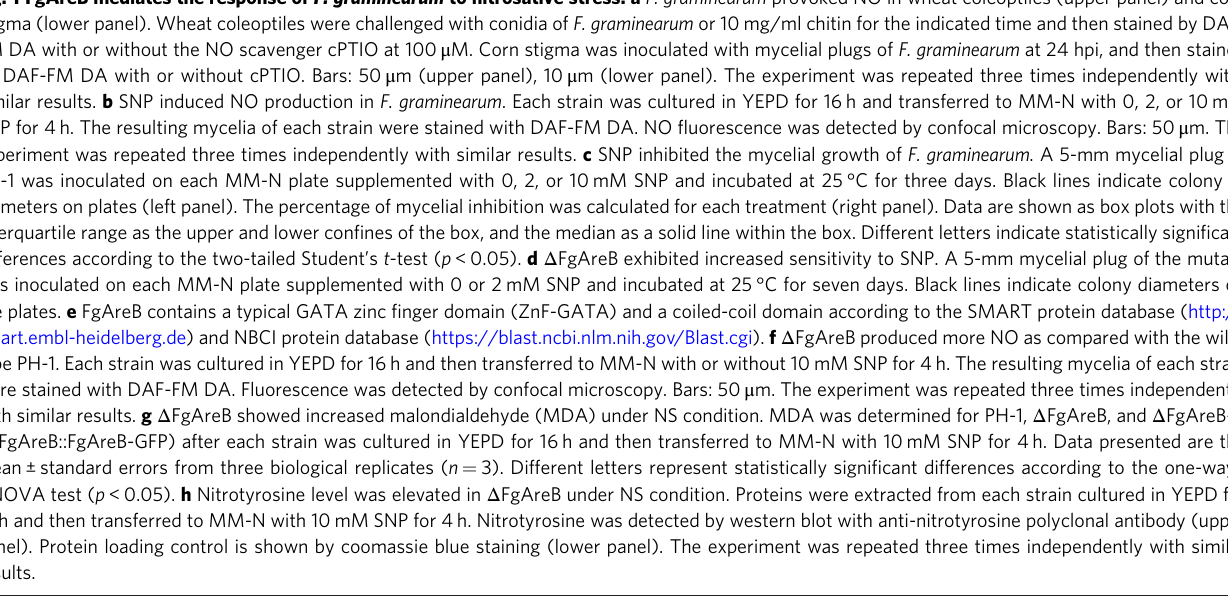
Fig. 1 FgAreB mediates the response of F. graminearum to nitrosative stress. a F. graminearum provoked NO in wheat coleoptiles (upper panel) and corn stigma (lower panel). Wheat coleoptiles were challenged with conidia of F. graminearum or 10 mg/ml chitin for the indicated time and then stained by DAF- FM DA with or without the NO scavenger cPTIO at 100 μ M. Corn stigma was inoculated with mycelial plugs of F. graminearum at 24 hpi, and then stained by DAF-FM DA with or without cPTIO. Bars: 50 μ m (upper panel), 10 μ m (lower panel). The experiment was repeated three times independently with similar results. b SNP induced NO production in F. graminearum . Each strain was cultured in YEPD for 16 h and transferred to MM-N with 0, 2, or 10 mM SNP for 4 h. The resulting mycelia of each strain were stained with DAF-FM DA. NO fl uorescence was detected by confocal microscopy. Bars: 50 μ m. The experiment was repeated three times independently with similar results. c SNP inhibited the mycelial growth of F. graminearum . A 5-mm mycelial plug of PH-1 was inoculated on each MM-N plate supplemented with 0, 2, or 10 mM SNP and incubated at 25 °C for three days. Black lines indicate colony diameters on plates (left panel). The percentage of mycelial inhibition was calculated for each treatment (right panel). Data are shown as box plots with